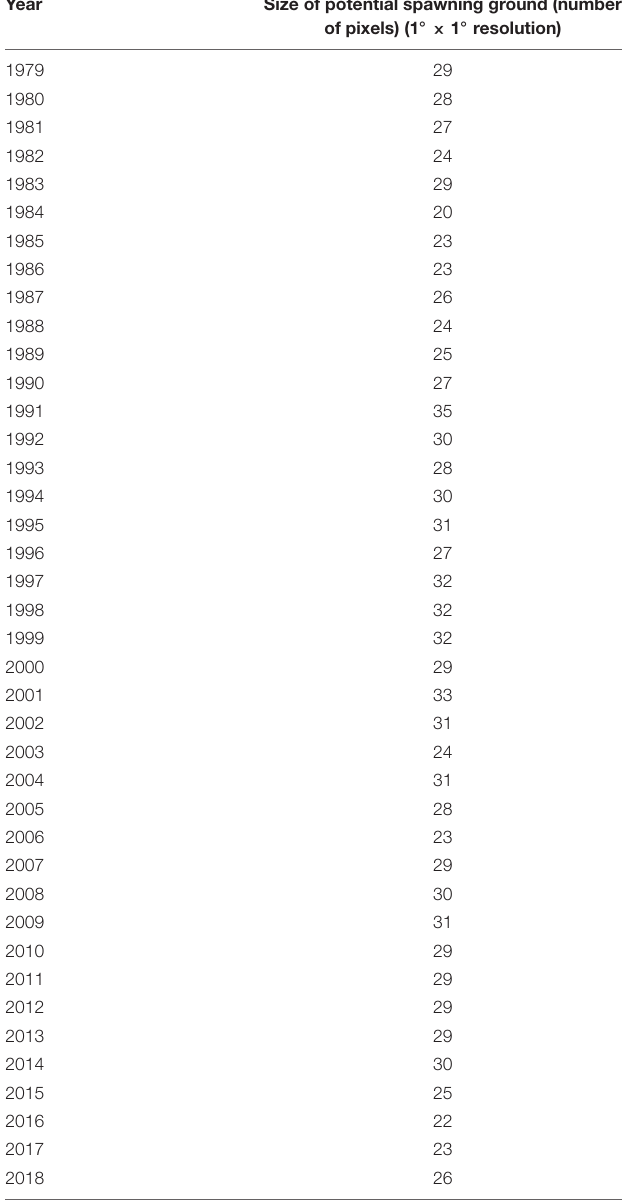
TABLE 2 | The annual size of potential spawning ground of winter cohort of Japanese flying squid from 1979 to 2018, based on the total number of 1 ◦ × 1 ◦ pixels.